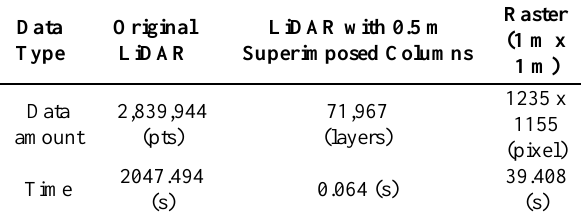
Table 5 . Data information of point B